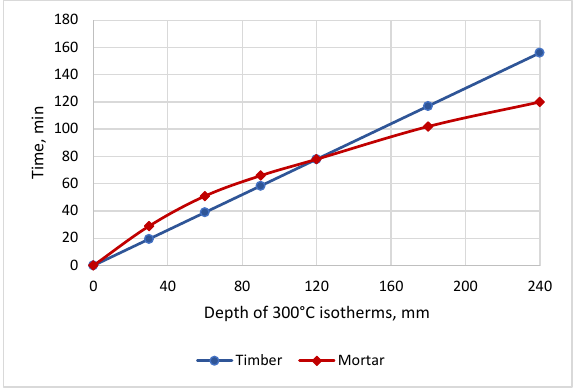
Figure 3. Depth of 300 °C isotherms for timber and concrete wall. Table 2. Depth of 300 °C isotherms for timber and mortar wall in case of double-sided fire for walls with thicknesses b equal to 200 mm, 300 mm and 400 mm and more.